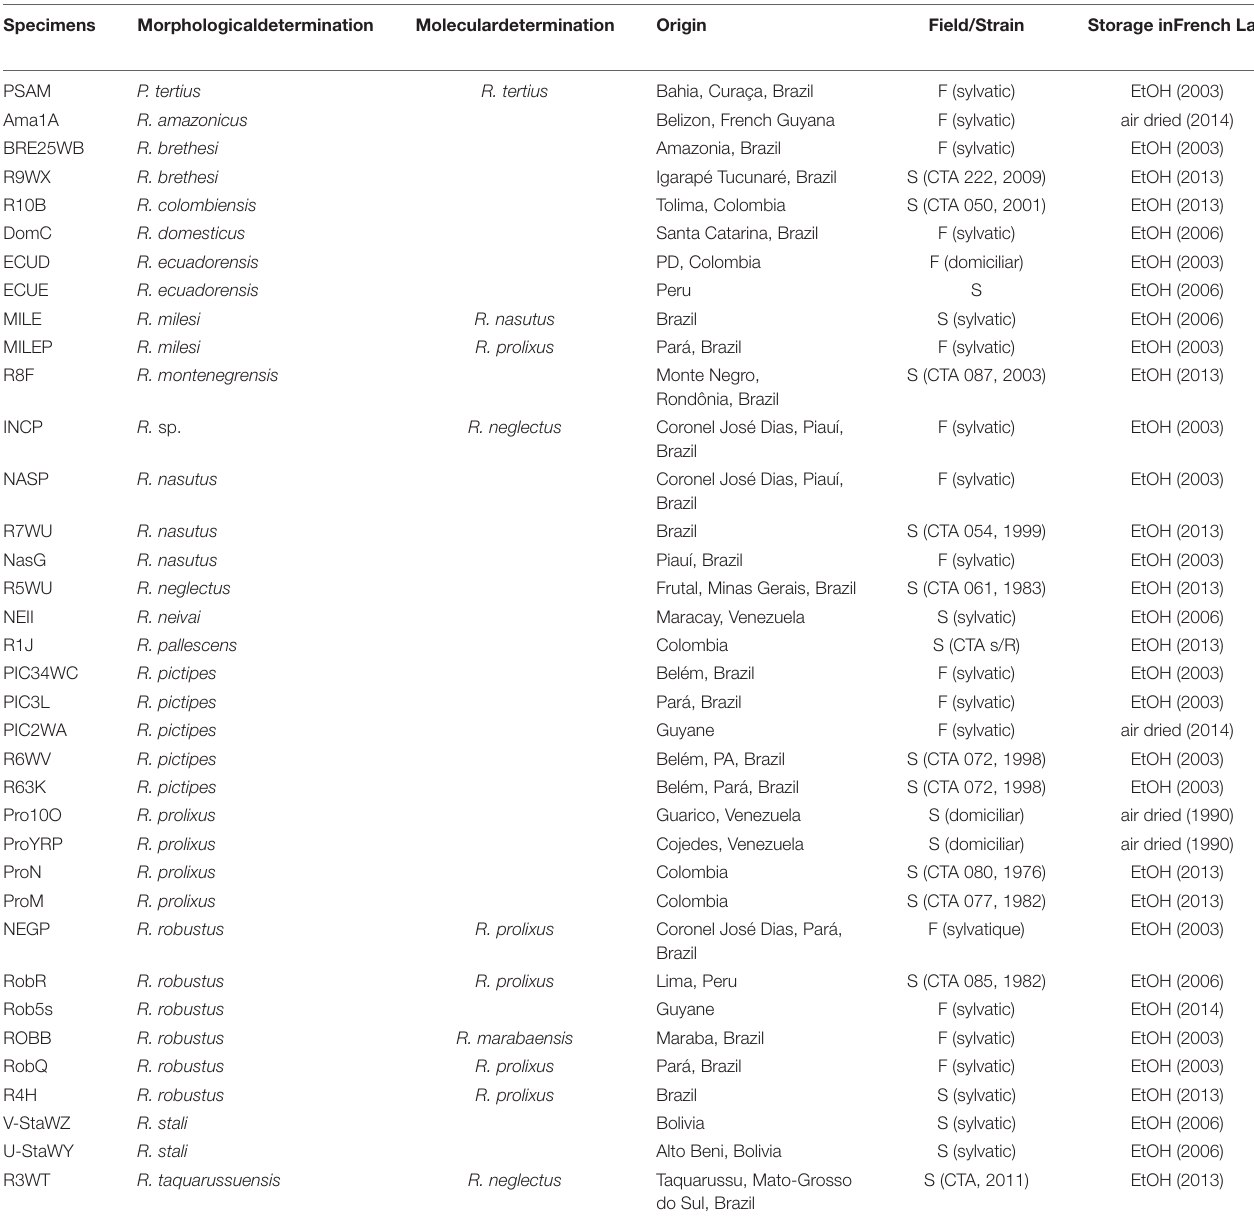
TABLE 2 | Specimens used in the